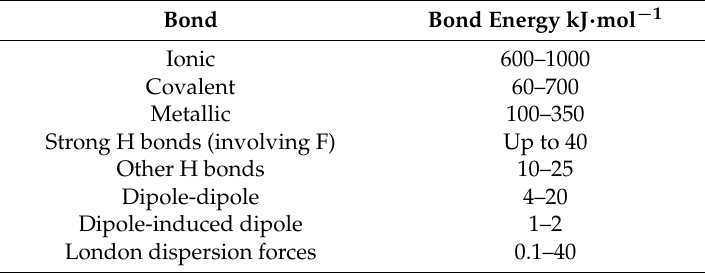
Table 8. Bond strengths at the interface [35].